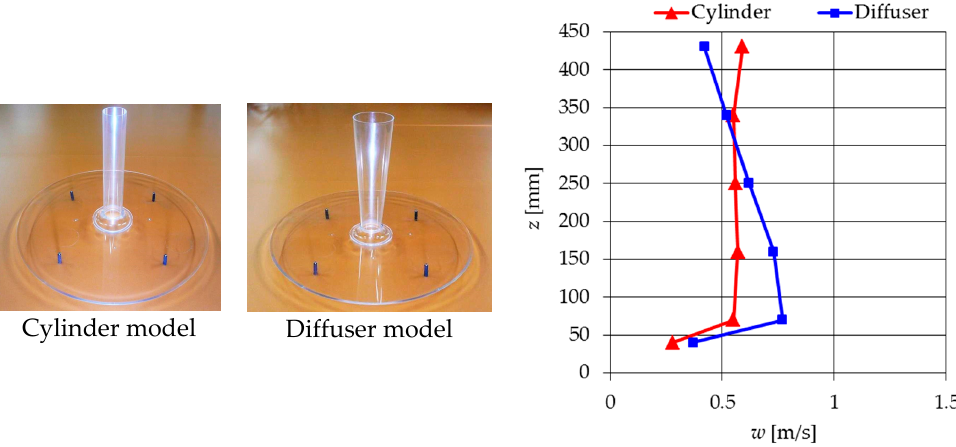
Figure 3. Thermal updraft speed w (m/s) with height z (mm) for temperature difference ∆ Θ of ~20 K.